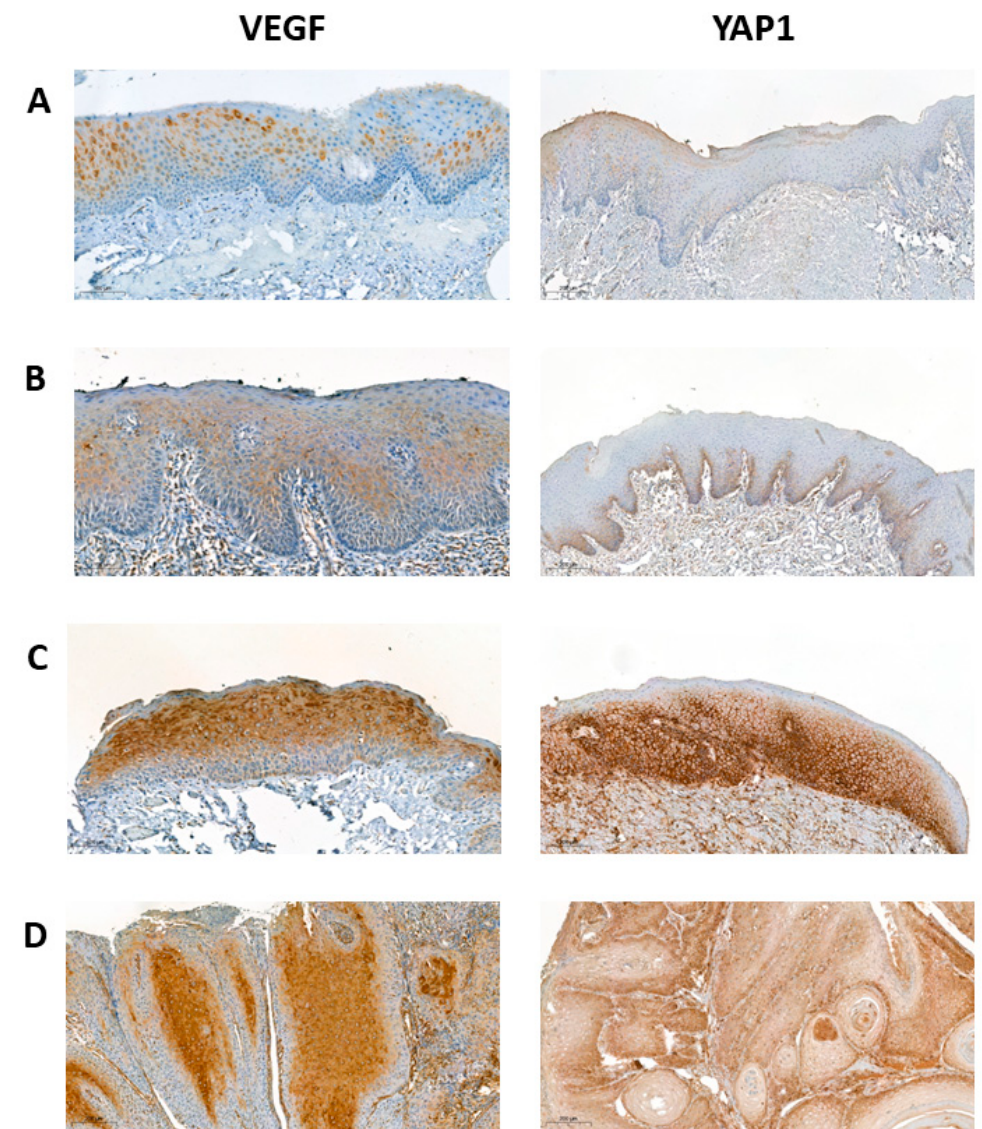
Figure 3. Representative photomicrographs show VEGF and YAP1 expression among ( A ): epithelial hyperkeratosis, ( B ): low-risk OED, ( C ): high-risk OED, and ( D ): OSCC (magnification × 100). Table 3. Quantitative assessment of invasion in the chemoprevention assay performed on transformed HOK and DOK spheroids treated with pazopanib and lenvatinib using one-way ANOVA. Transformed HOK Spheroids Transformed DOK Spheroids Length ( µ m) Area ( µ m 2 ) Length ( µ m) Area ( µ m 2 ) Control 341.6 ± 40.9 50,718 ± 814.0 614.2 ± 39.4 125,235.7 ± 3158.1 Pazopanib-treated 153.8 ± 29.3 * 14,862.8 ± 2683.2 * 373.8 ± 49.3 * 71,685.5 ± 16,675.1 * 15,486.0 ± 4136.3 * 341.3 ± 20.0